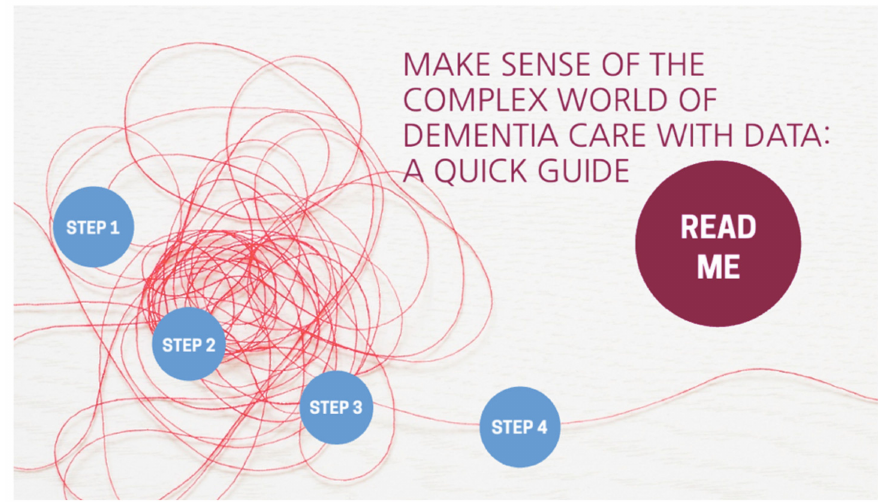
Figure 6. Home page of the data exploration guide.